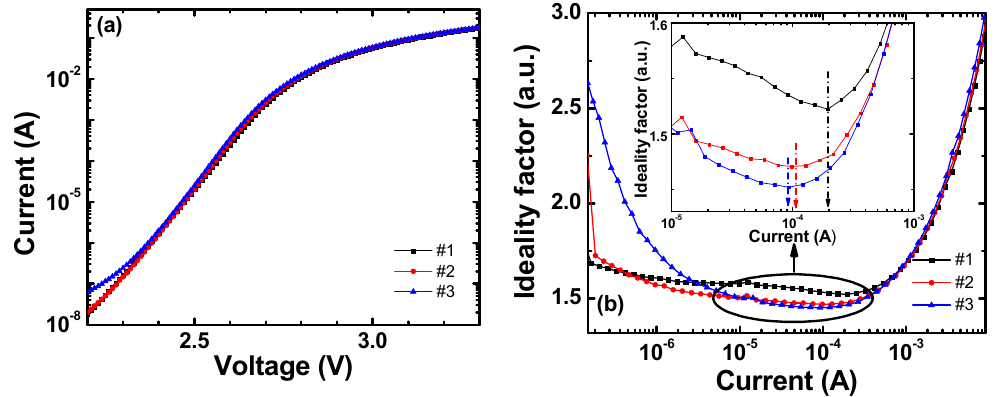
Figure 4. ( a ) I-V characteristics on semi-log scales and ( b ) calculated IFs from the I-V characteristics. The inset shows the ideality factor of all samples from 2.50 to 2.65 V.